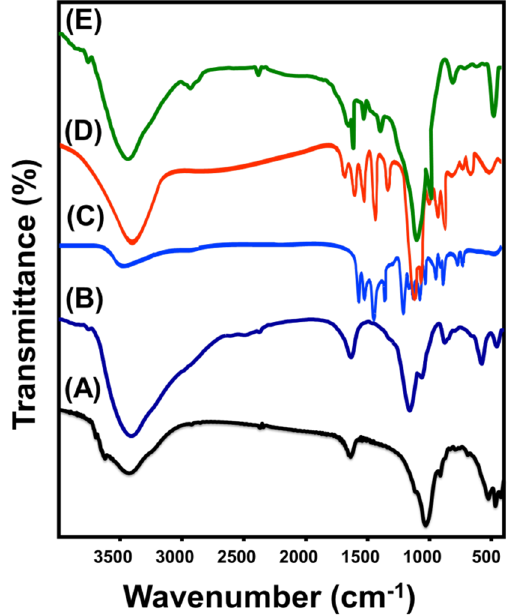
Figure 3. FT–IR spectrum of raw bentonite ( A ), acid-activated bentonite ( B ), curcumin powder ( C ), synthetic CN/BE composite ( D ), and synthetic Zn@CN/BE composite ( E ).